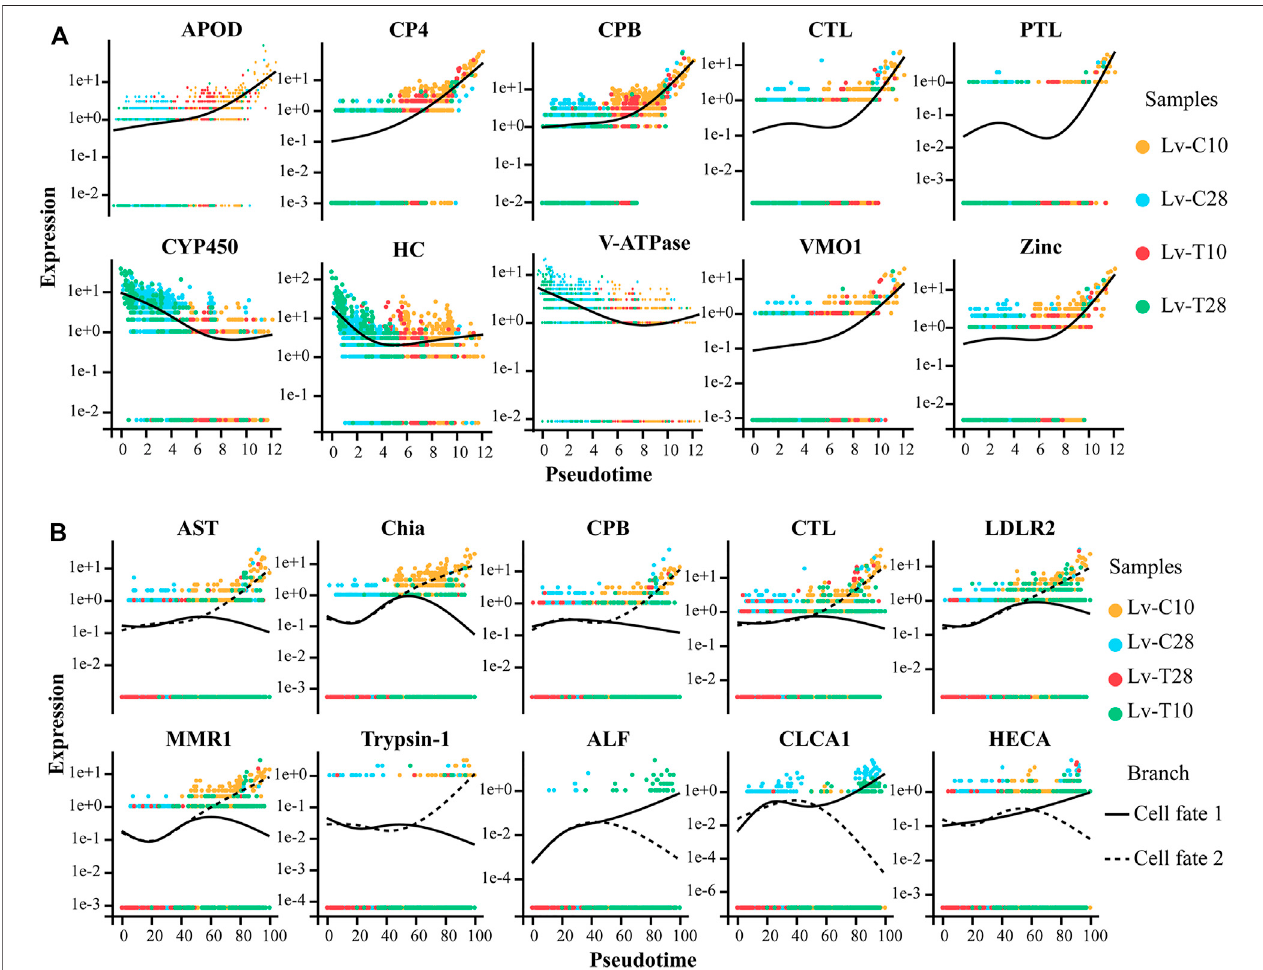
FIGURE6| Expressionpatternsofgenesincold-tolerantandwild-type Litopenaeusvannamei inresponsetocoldstressoverpseudo-time.Yellow dotrepresents common at 10 ° C, blue dot represents common at 28 ° C, red dot represents cold-tolerant at 10 ° C, and green dot represents cold-tolerant at 28 ° C. (A) Gene expression patterns in cells with similar fates after cold stress. Solid black line represents best fi t line for gene expression level. (B) Gene expression patterns in cells with different fatesaftercoldstress.Solidblacklinerepresentsthebest fi tlinefortheexpressionlevelsofgenesincellsassociatedwithcellfate1,andthedashedlinerepresents the best fi t line for the expression levels of genes in cells associated with cell fate